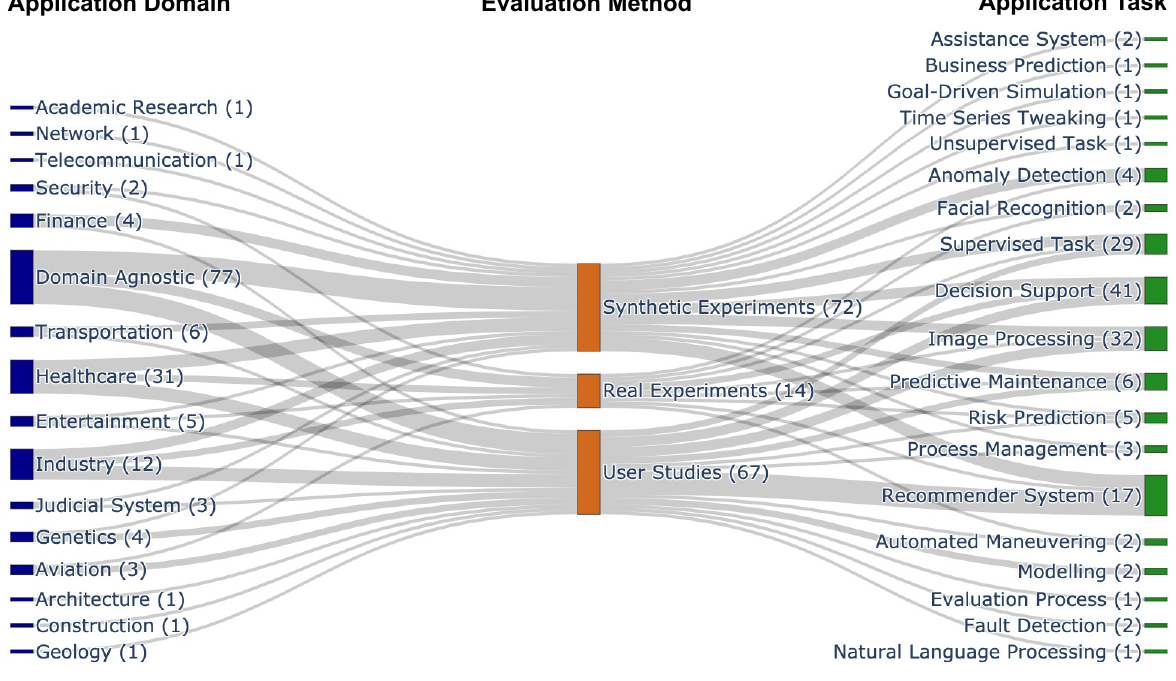
Figure 14. Different methods of evaluating explanations which were presented in the selected articles with the number of studies given in parentheses. Corresponding application domains and tasks of the performed evaluation methods are illustrated with links. The widths of the links are proportional to the number of studies. Some of the studies invoked a combination of different evaluation